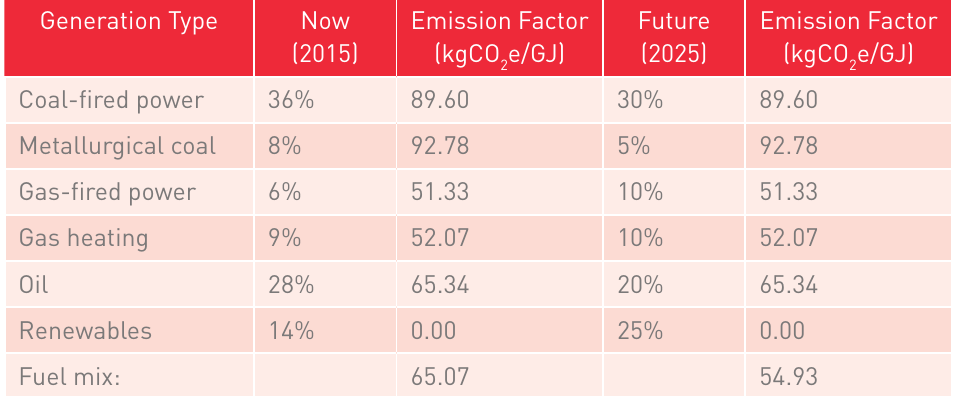
Australia electricity generation mix – source: Langston (2015) Generation